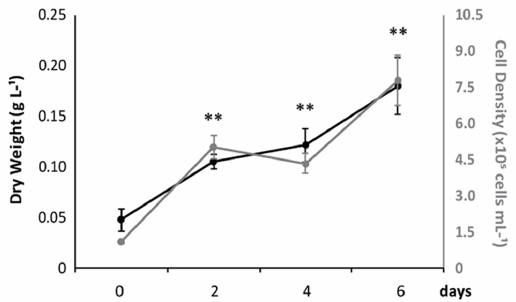
Figure 1. Growth rate and biomass production of H. coffeaeformis. The concentration of cells (grey) and the rate of biomass generation (black) (average ± standard deviation, n = 3) are shown, expressed as cells∙mL −1 and g of dry weight∙L −1 , respectively.